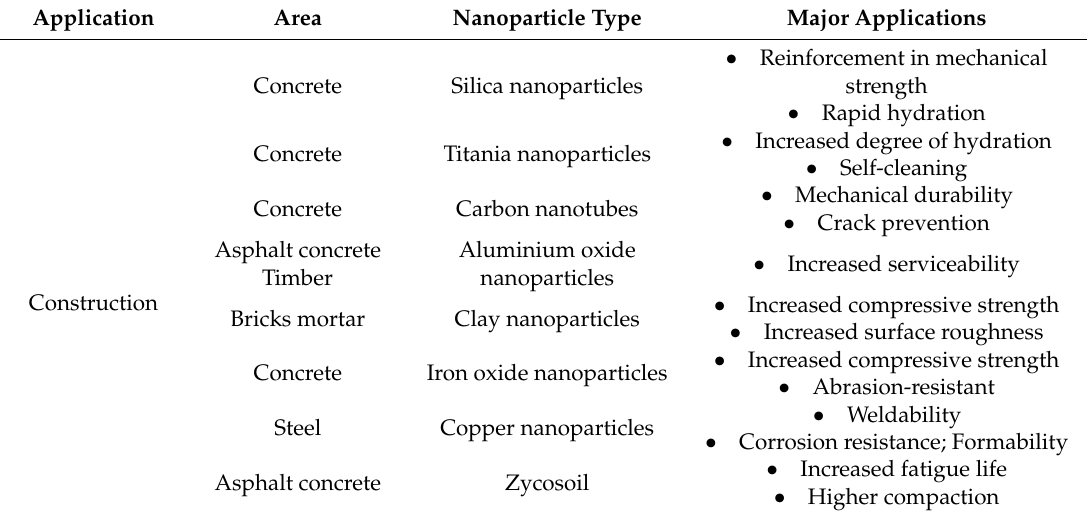
Table 1. Nanomaterials used in construction